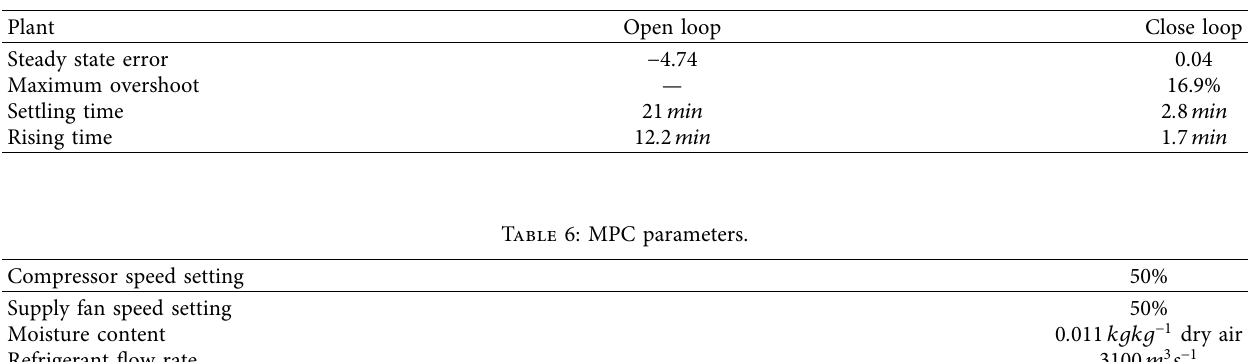
Table 5: Plant performance indicators.